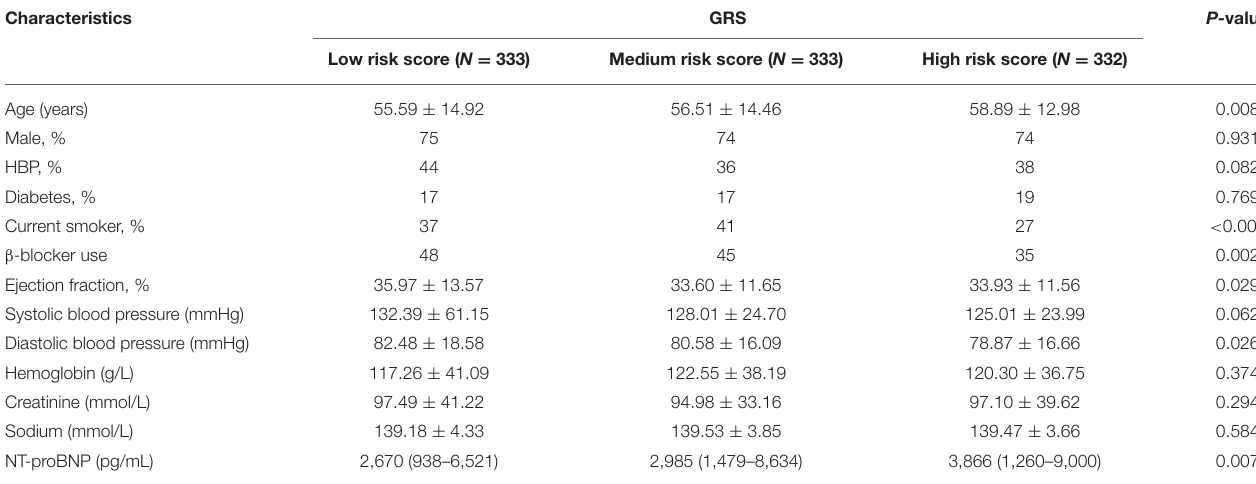
TABLE 4 | Baseline clinical characteristics of the study cohort with different risk score.